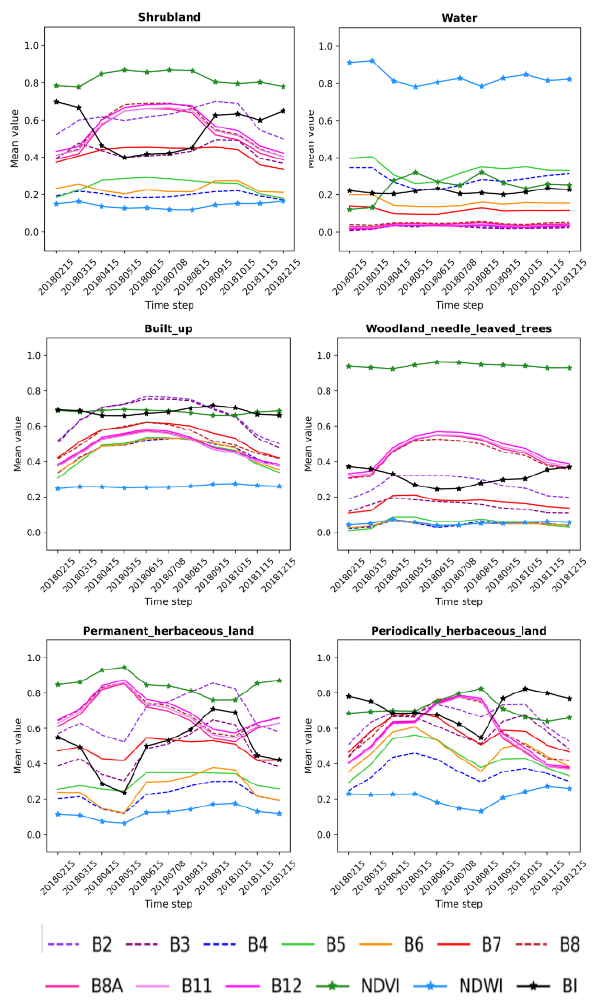
Figure 8. Examples of normalized spectral features time series per class.